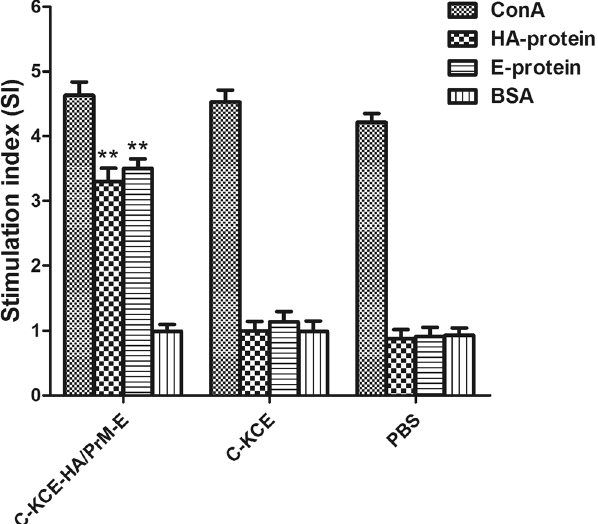
Figure 6. Peripheral blood T-lymphocyte proliferation assay. Ducks were vaccinated with PBS, 10 5 PFU of C-KCE or C-KCE-HA/PrM-E (n = 3 per group) subcutaneously. On the day of final immunization (day 14), duck peripheral blood lymphocytes were evaluated by MTT assay. Data are shown as the mean ± SD. Statistically significant differences ( P < 0.01) are indicated by ** (compared with C-KCE or PBS group). ConA, Concanavalin